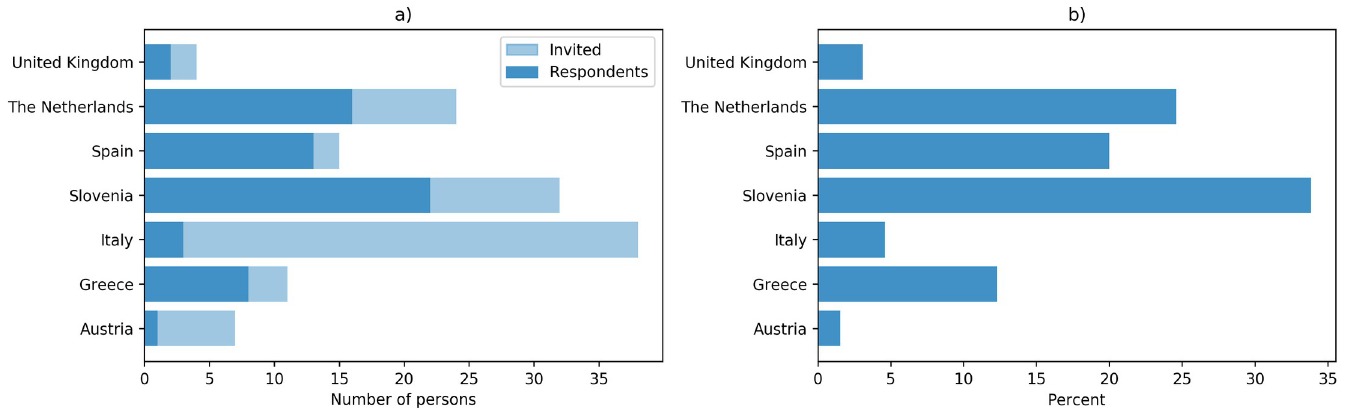
Fig 5. a) Invited healthcare providers vs. number of respondents per country, b) Percentage of respondents per